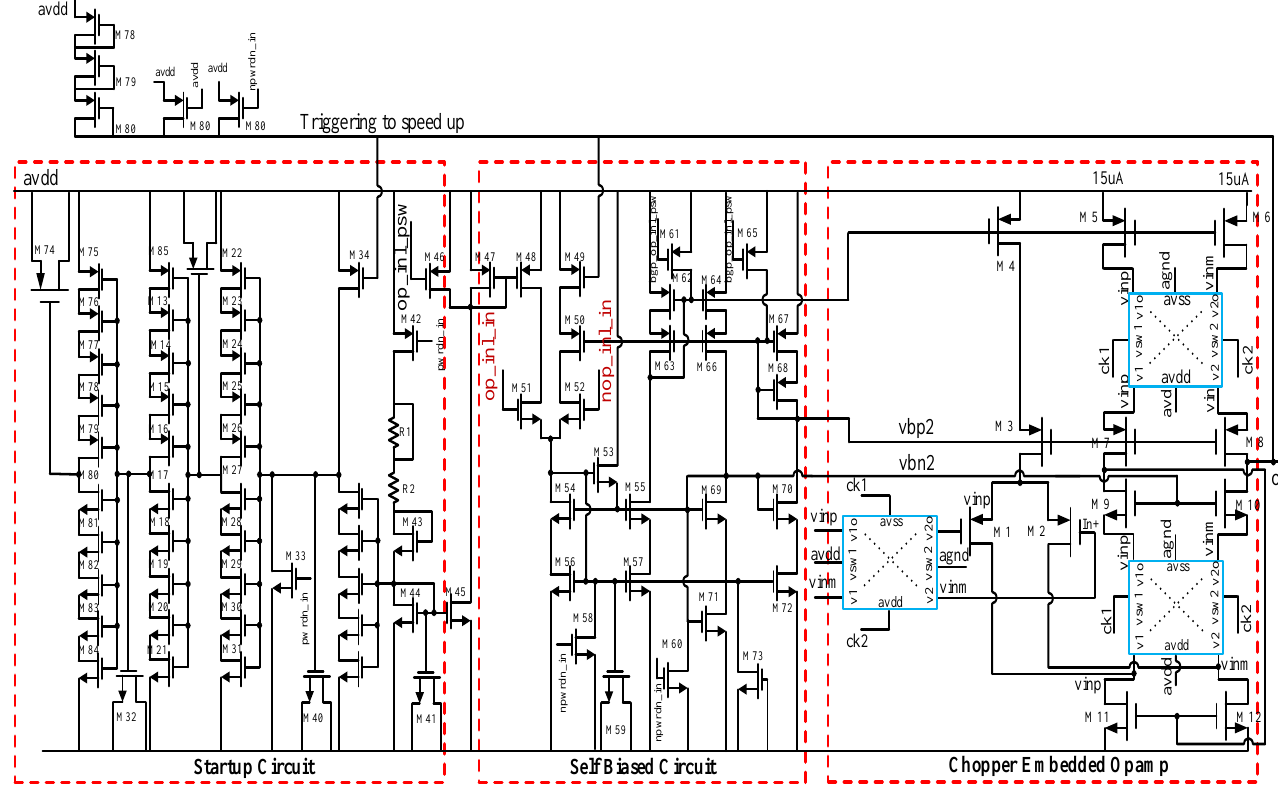
Figure 2. Chopper-stabilized operational amplifier circuit of the BGR.